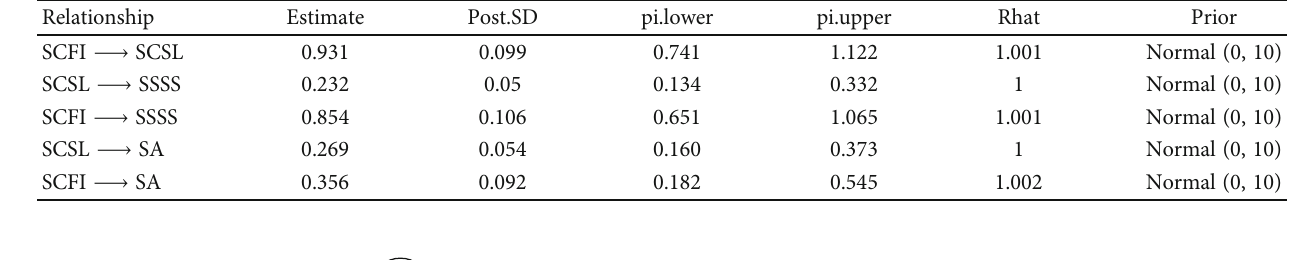
Table 7: Parameter estimate BSEM.